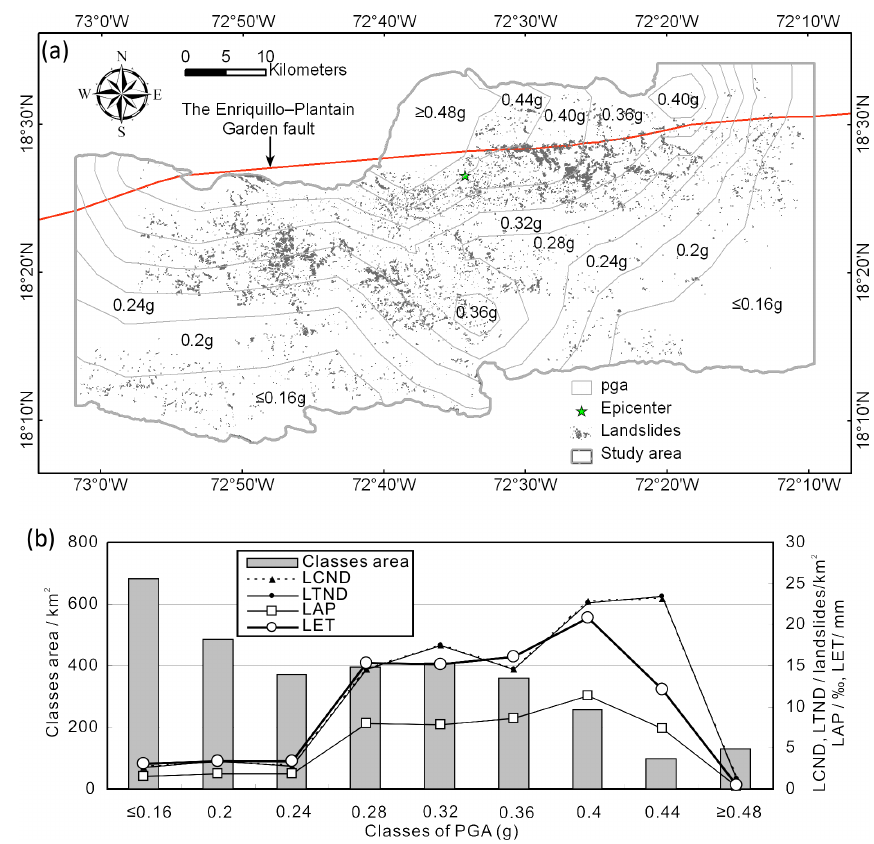
Figure 25. (a) Distribution of PGA values of the study area and (b) relationships of co-seismic landslides and PGA.